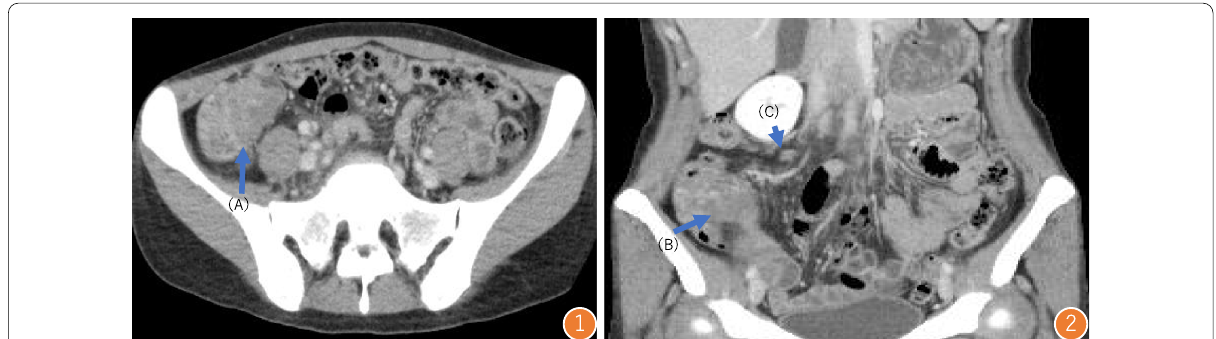
Fig. 1 Contrast-enhanced CT. ① : Axial view: A thickness of the cecal wall. ② : Coronal view: B thickening of the cecal wall is observed. C Enlarged regional lymph nodes are seen